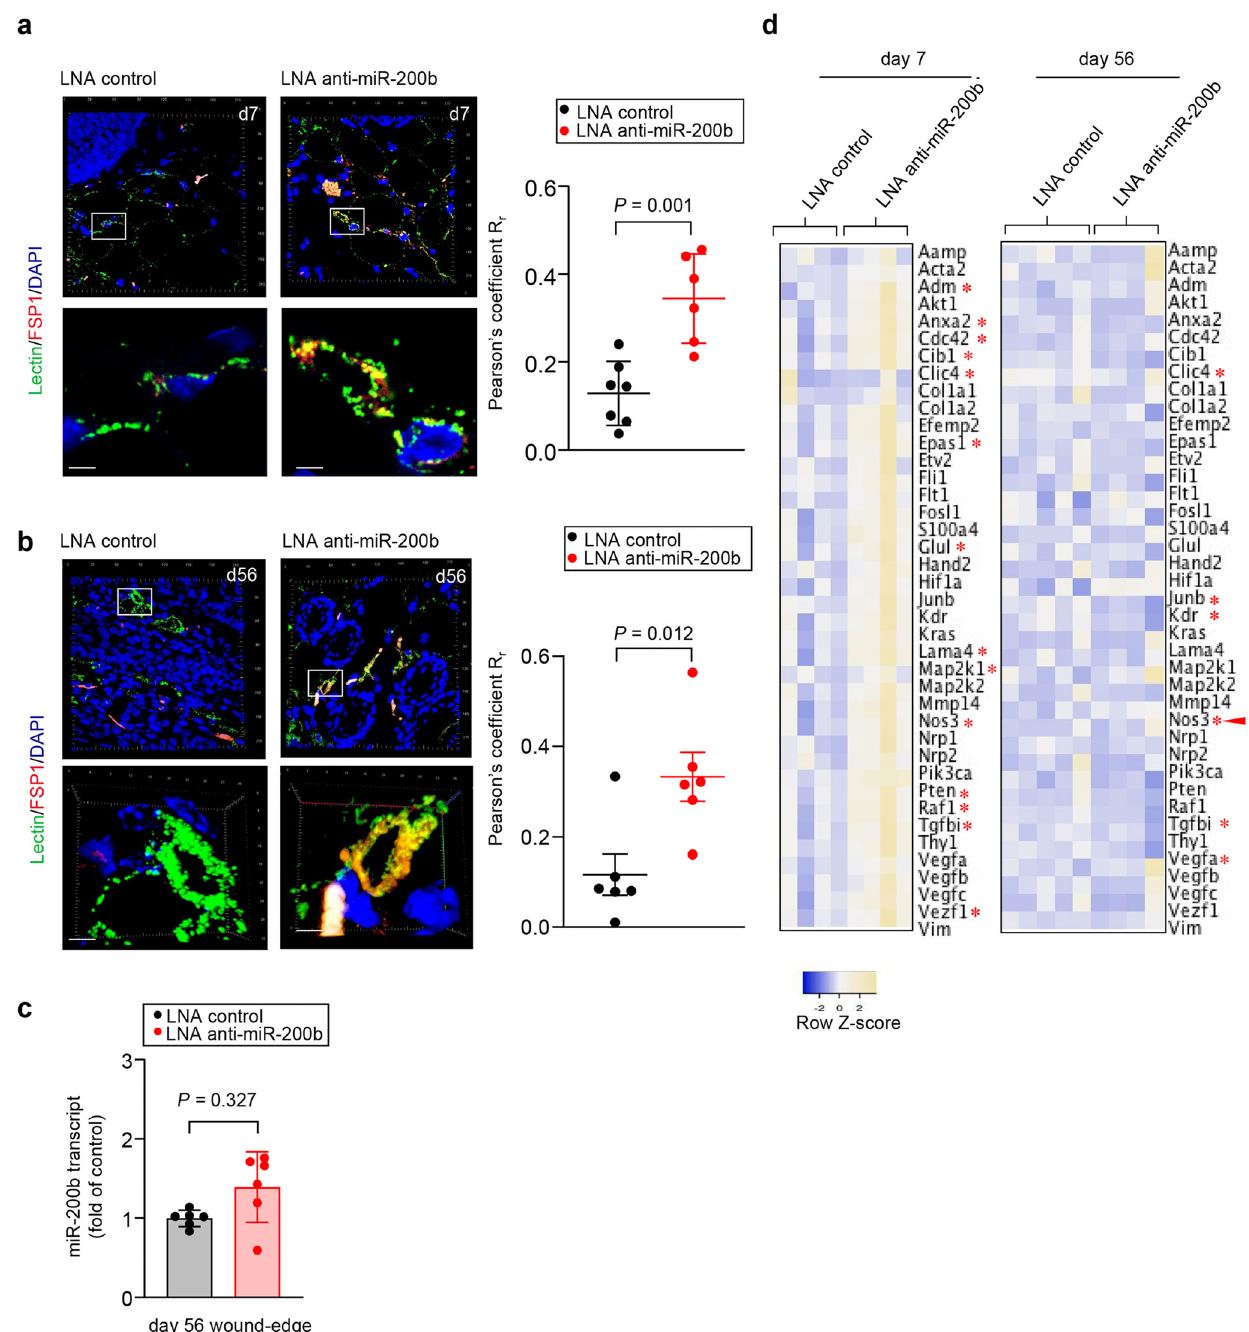
Fig. 6 | Topical LNA-anti-miR-200b induces emergence of vasculogenic fi bro- blasts in cutaneous wounds. a , b Immuno fl uorescence confocal image of day 7 wounds in Fsp1-Cre tdTomato mice treated with LNA control and LNA anti-miR 200b inhibitor showing lectin perfused Fsp1 positive vessels. Scale, 20 µ m. The images showing the colocalization of lectin and Fsp1 in the 3Dcross-sectionalview renderedbyZensoftware( n =6 – 7). c miR-200bexpressioninwound-edgetissueof Fsp1-CretdTomatomicetreatedwithLNAcontrolandLNAanti-miR200binhibitor